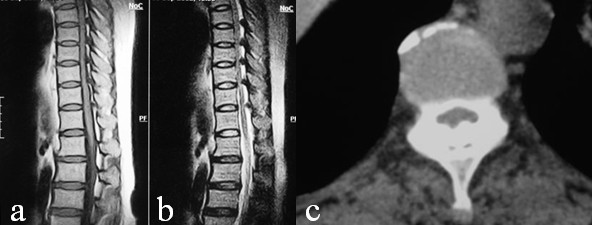
a, b. T1 and T2 weight MRI of thoracic spine showed continuous multi-level ossification of ligamentum flavum between T7–12. c. CT scan showed ossified ligamentum flavum, note that there was a thin gap between the ossified ligament and the lamina.